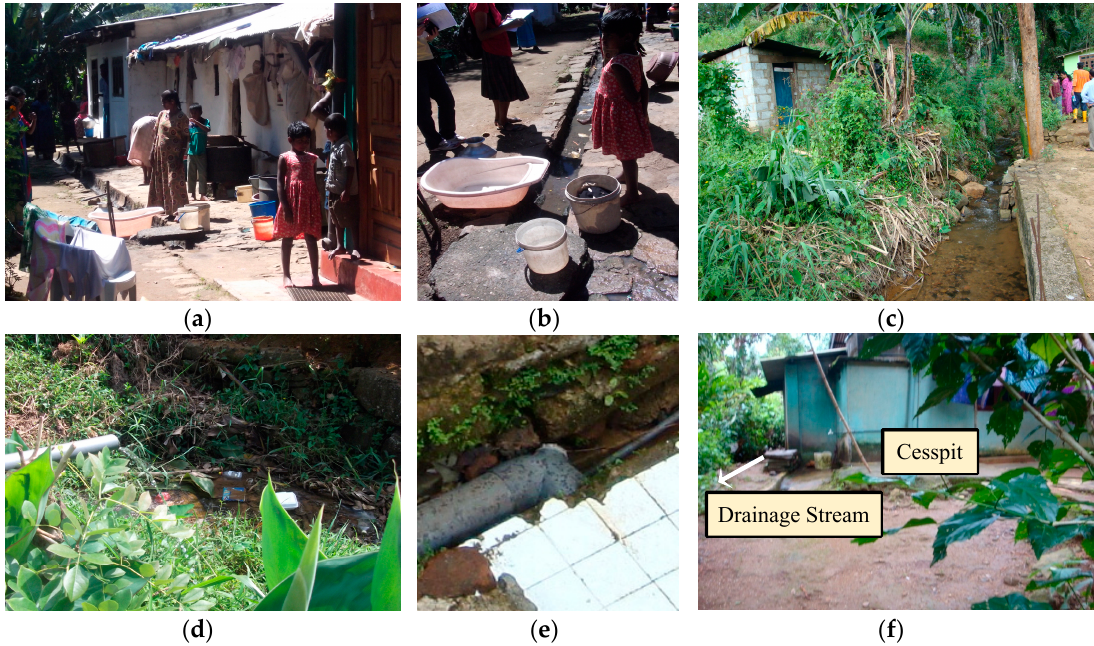
Figure 2. Photographs of the environmental conditions at locations in the study area. ( a ) A congested row of line houses. ( b ) A polluted drain which flows to the stream. ( c ) A pit latrine close to the drain.